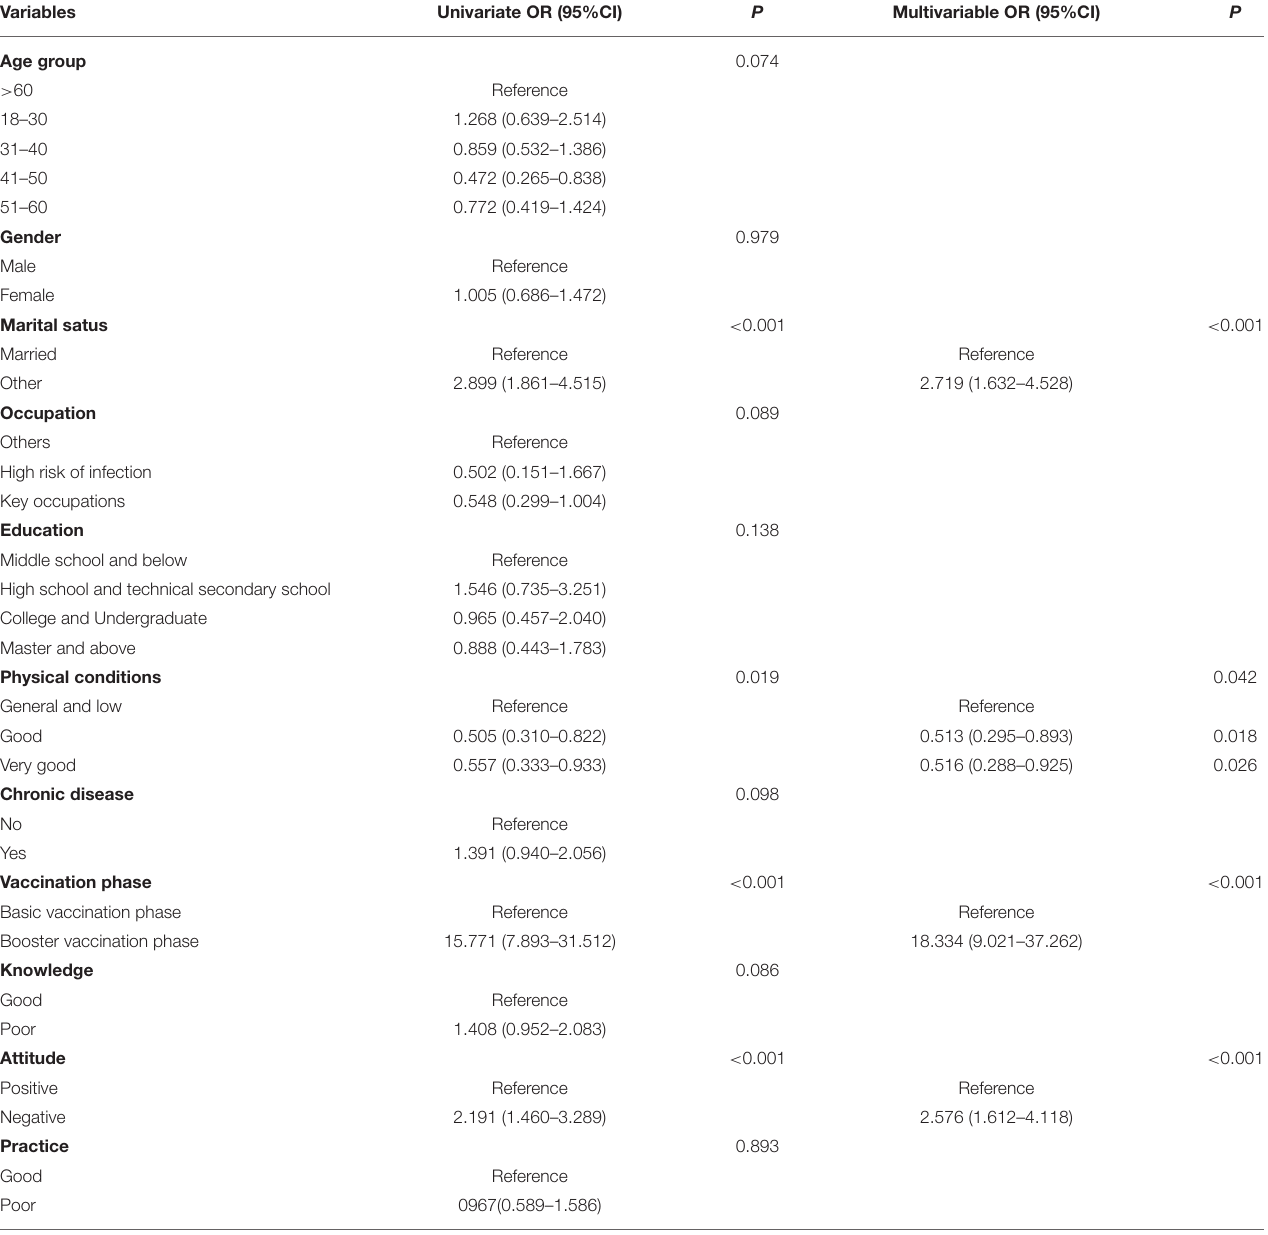
TABLE 5 | Logistic regression analysis of factors affecting COVID-19 vaccine hesitancy of survey